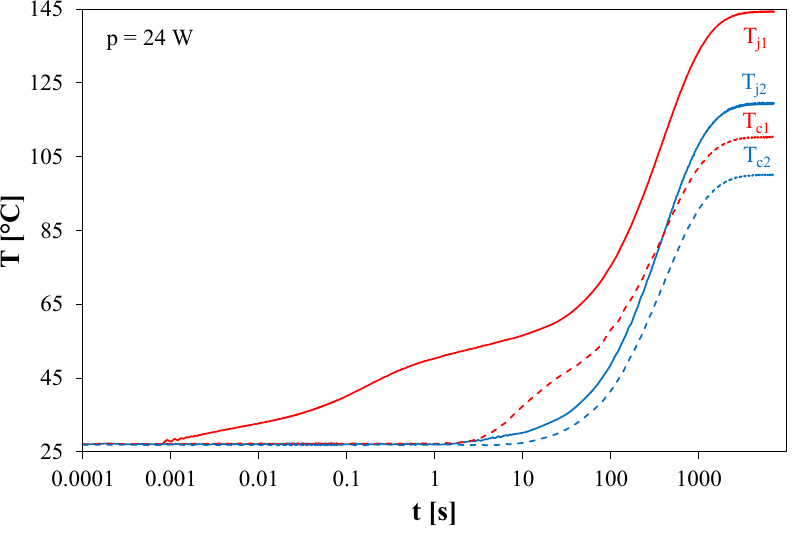
Figure 15. Waveforms of the internal temperature T j and the case temperature Tc for transistors M 1 and M 2 at the power of 24 W dissipated in transistor M 1.